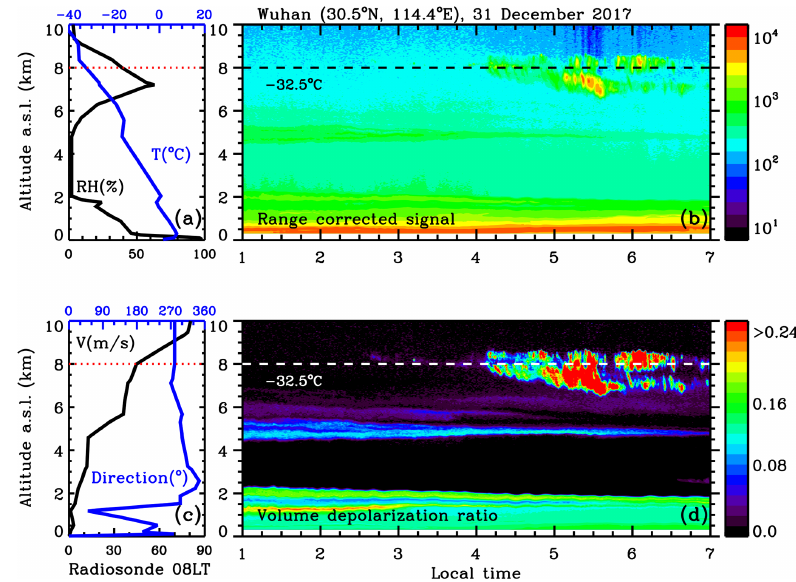
Figure 8. Time–height contour plots (1min/30m resolution) of (b) range-corrected signal and (d) volume depolarization ratio measured by a 532nm polarization lidar on 31 December 2017. Height profiles of (a) temperature and relative humidity and (c) wind speed and wind direction measured with the radiosonde launched at 08:00LT. Horizontal lines indicate the − 32.5 ◦ C temperature height levels.